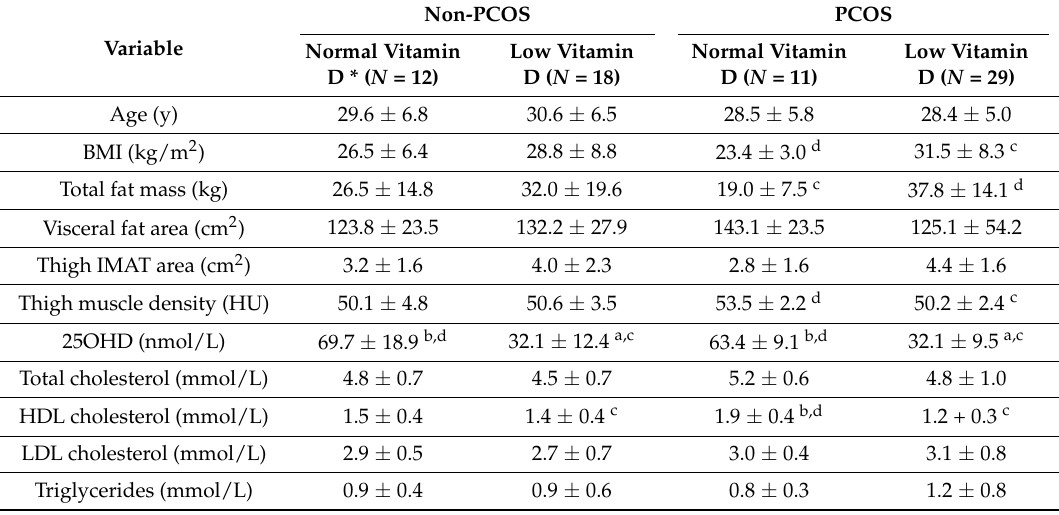
Table 1. Baseline characteristics of participants according to polycstic ovary syndrome (PCOS) and vitamin D